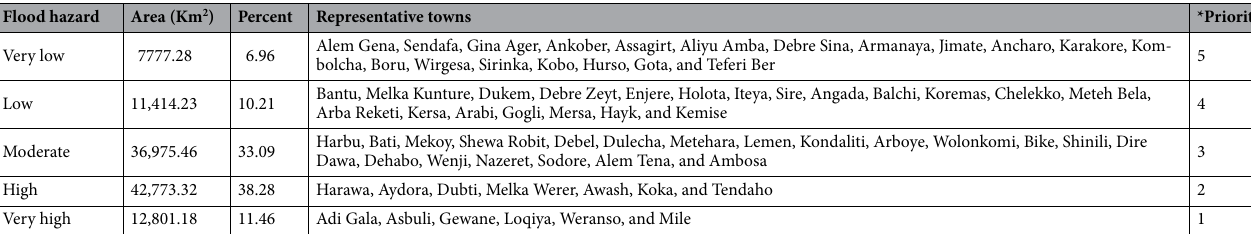
Table 2. Areal extent of flood vulnerability in the Awash basin, Ethiopia. *Priority: 1–5; where 1 means the highest priority and 5 means the lowest priority.